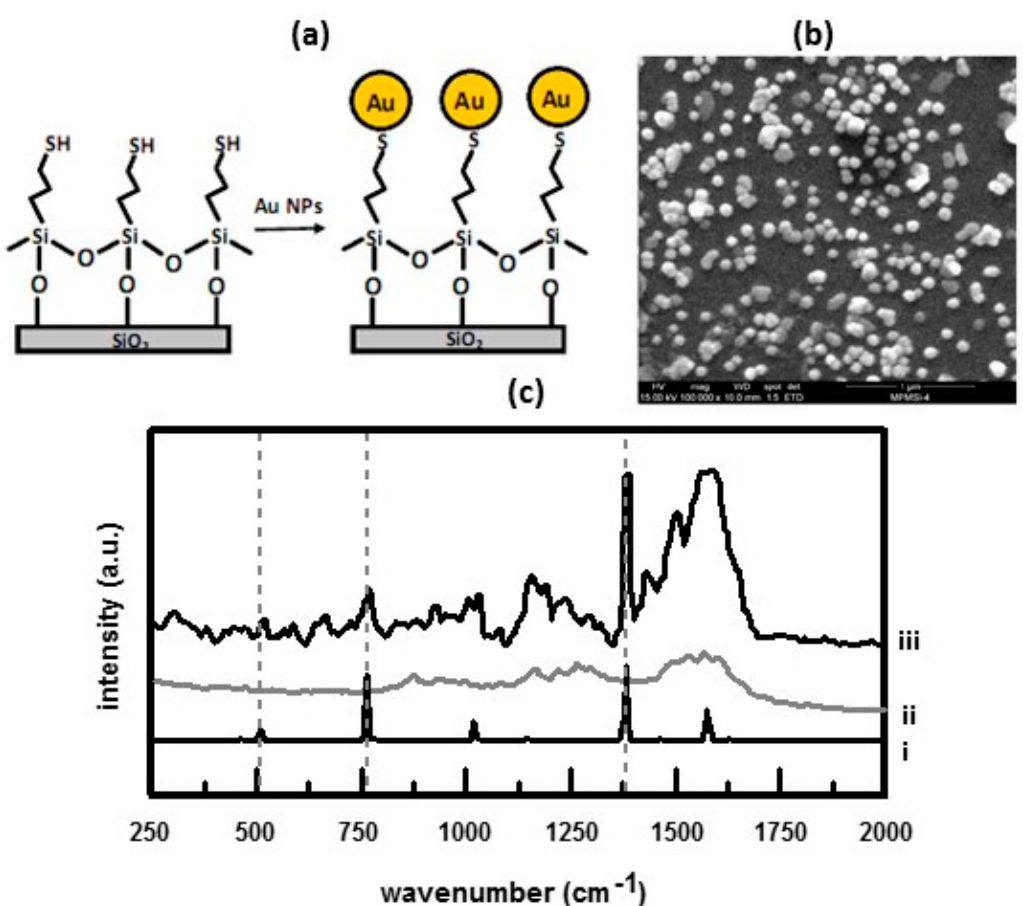
Figure 6. ( a ) Schematic representation of the procedure to immobilize Au NPs on a quartz substrate; ( b ) SEM image showing Au NPs immobilized on a quartz substrate; ( c ) SERS spectra of a substrate in contact with artificial sea-water containing 25 ppm naphthalene (iii) and a substrate in artificial sea water (blank) (ii). For comparison the Raman spectrum, (i), of solid state naphthalene is also shown. Naphthalene peaks are indicated with dashed lines. Reproduced with permission from Elsevier, 2009 [6].